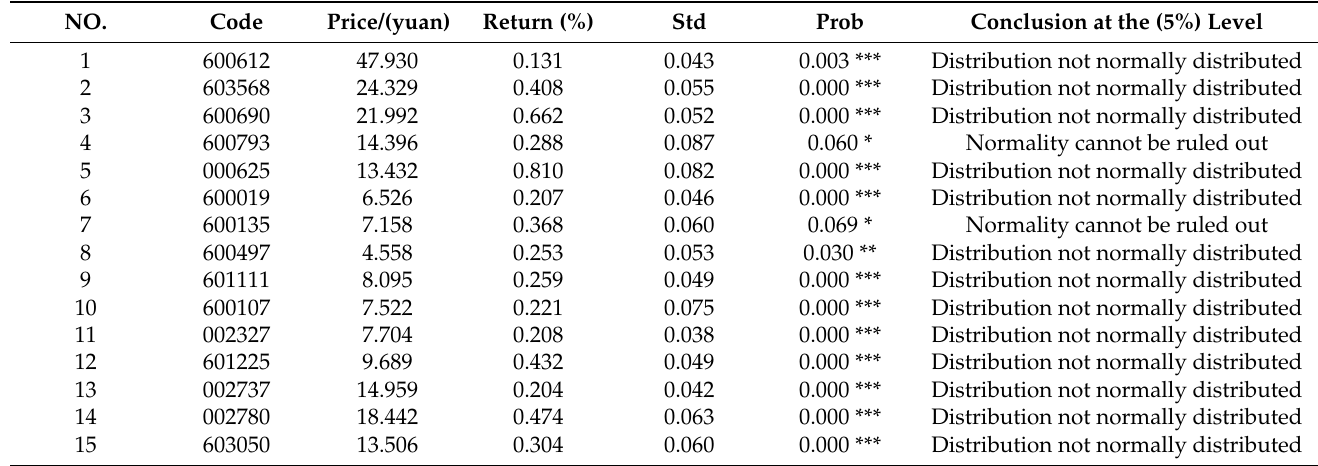
Table 4. Basic characteristics and normality test of 15 stocks from 2019 to